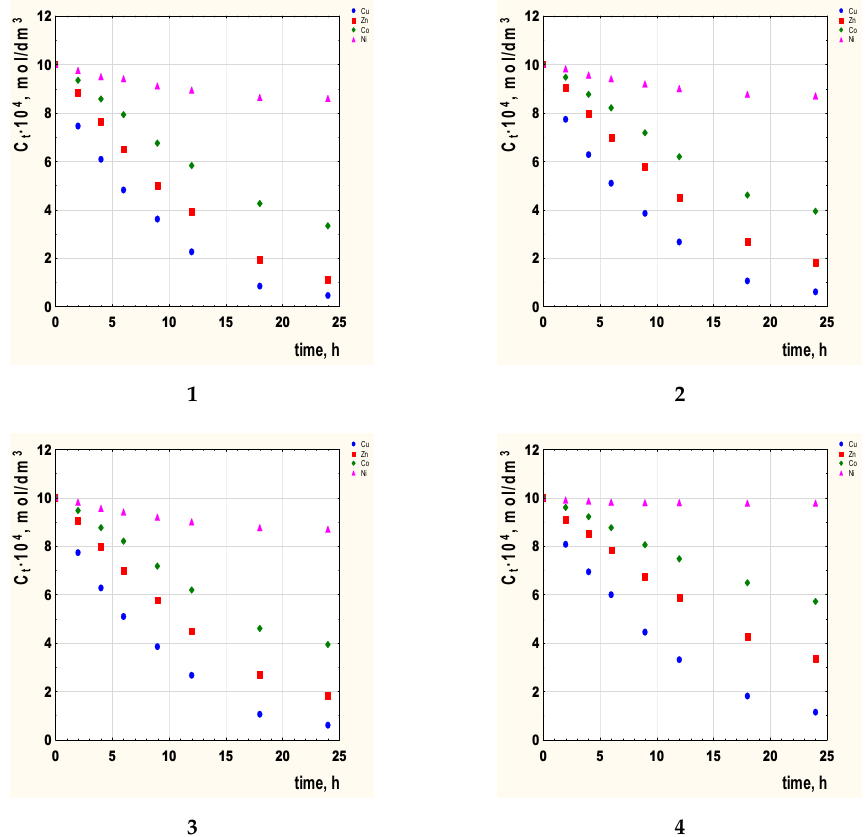
Figure 2. The concentration Cu(II), Zn(II), Co(II), and Ni(II) ions vs. time for PIMs with 2- alkylimidazole as the carrier. 2-methylimidazole ( 1 ), 2-ethylimidazole ( 2 ), 2-propylimidazole ( 3 ), and 2-butylimidazole ( 4 ). Membrane: 2.6 cm 3 o-NPPE/1 g CTA and 1.0 mol/dm 3